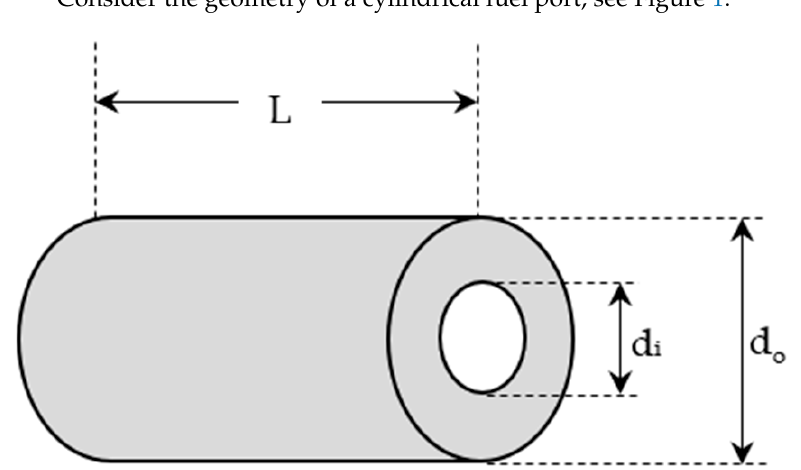
Figure 1. The main geometrical dimensions of a cylindrical fuel port.